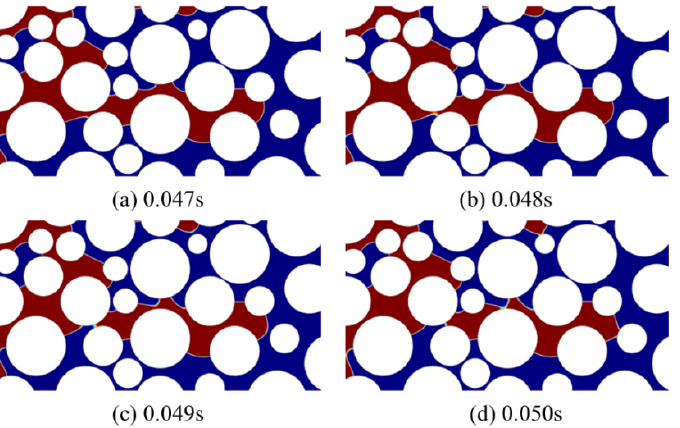
Figure 9. Fracture of the CO 2 plume during the displacement process (log Ca = − 4.62, log M = − 3.00; red and blue regions represent CO 2 and oil, respectively).